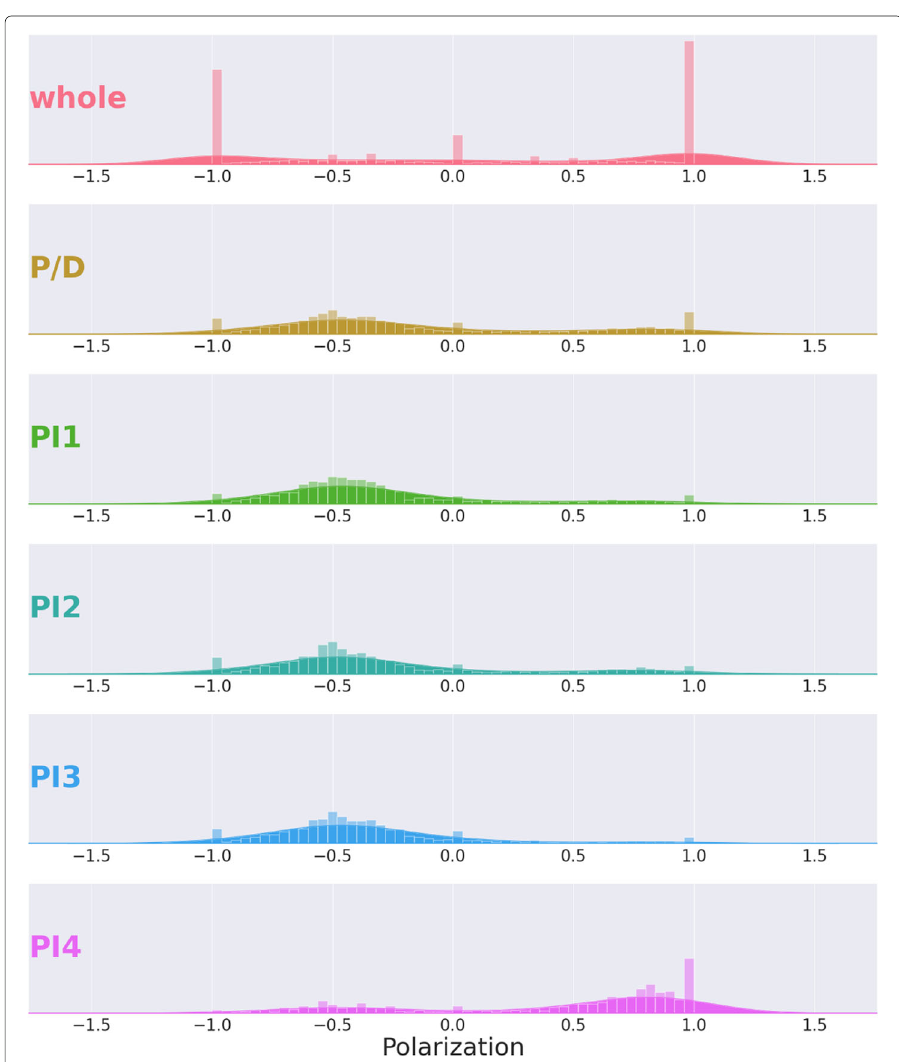
Fig. 3 Polarization of users involved in propaganda